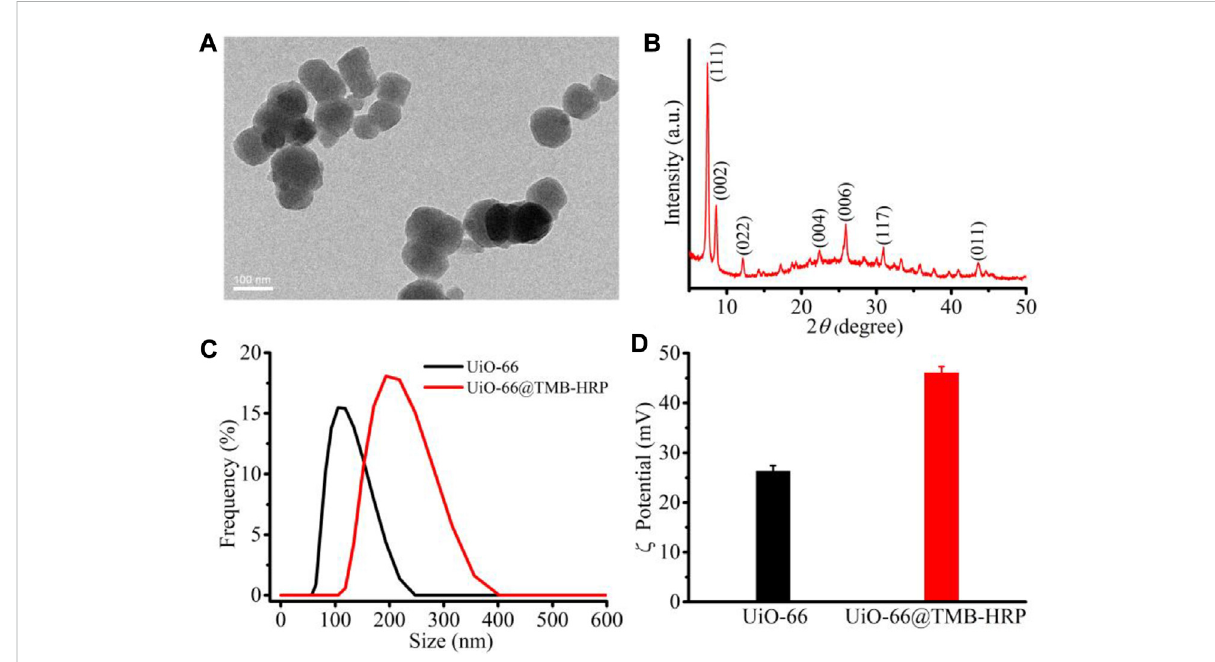
FIGURE 1 Characteristics of the nanocomposite preparation. TEM (A) image and XRD patterns (B) of the MOF (UiO-66), the size distribution (C) , and zeta potential (D) of the MOF and the obtained nanocomposite UiO-66@TMB-HRP (UTH).